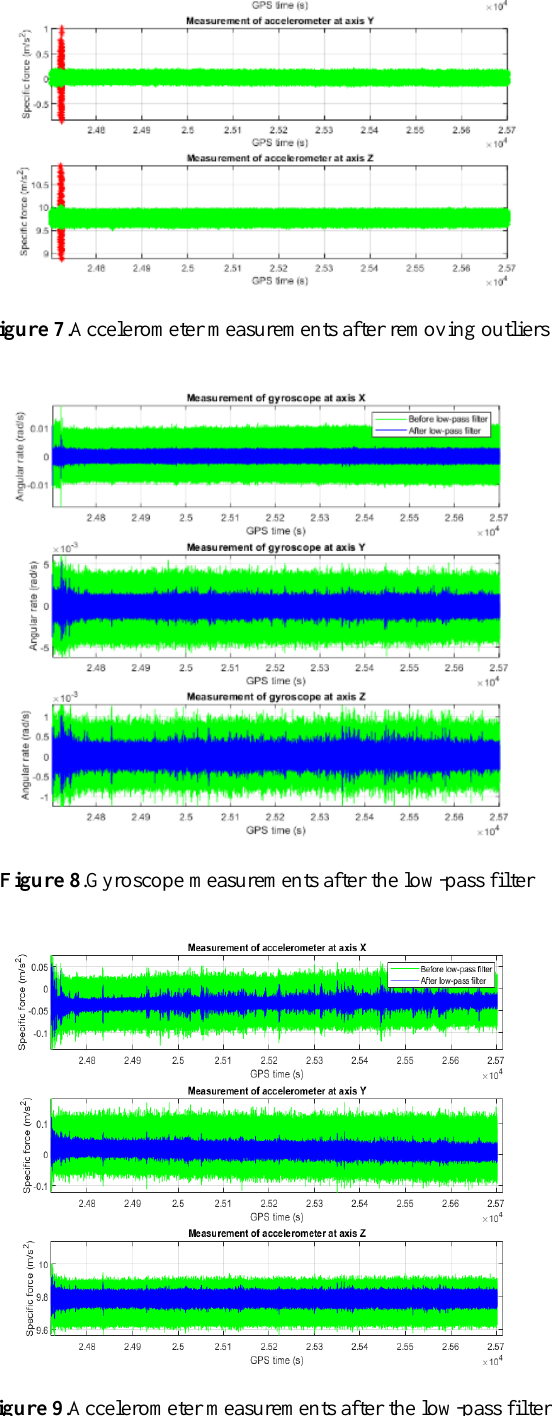
Figure 9 .Accelerometer measurements after the low-pass